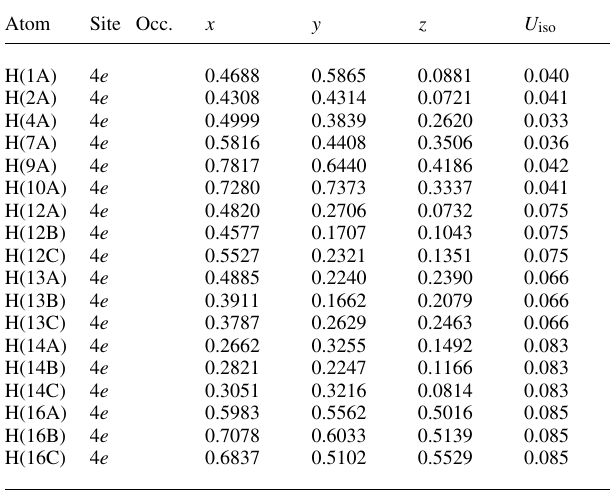
Table 2. Atomic coordinates and displacement parameters (in Å 2 )